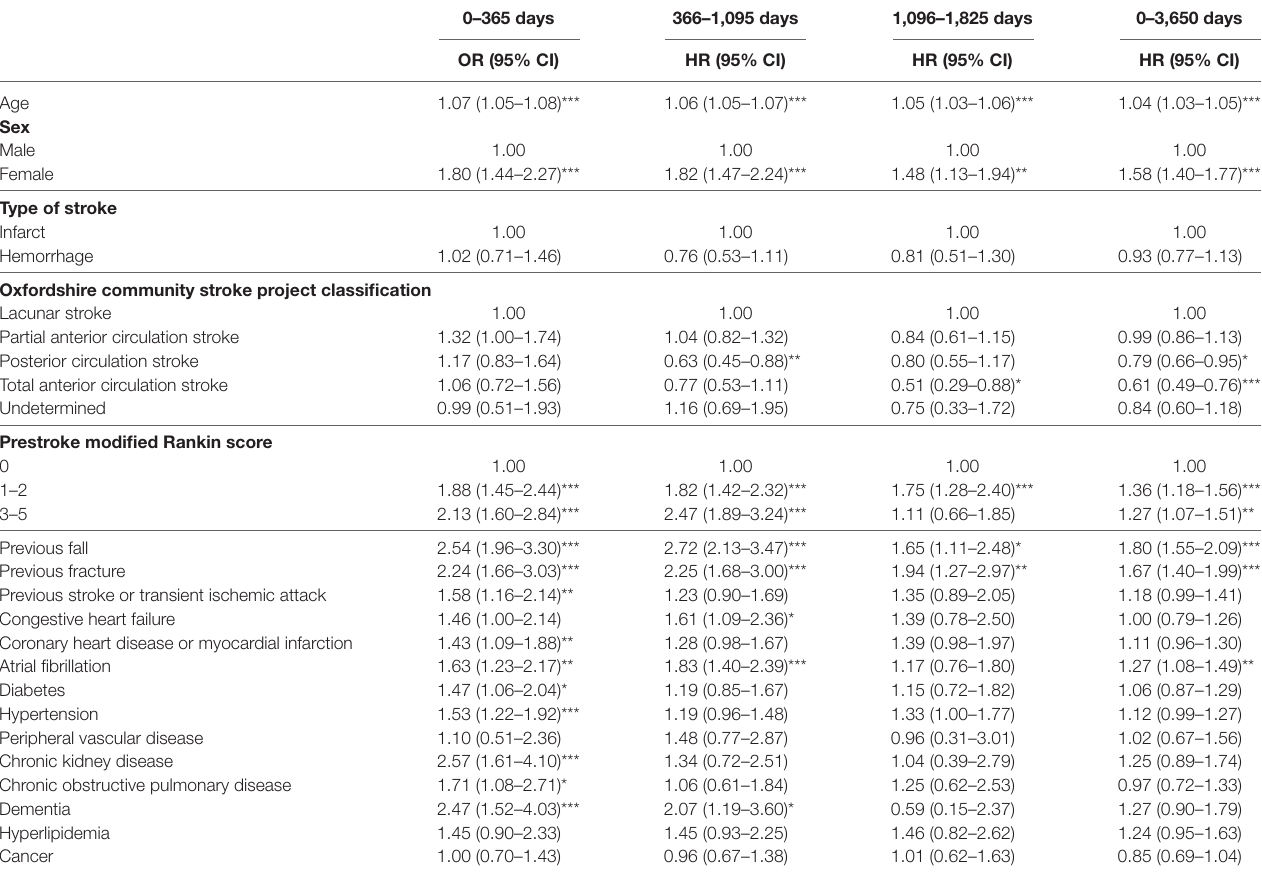
TaBle 2 | Univariate analysis of risk factors for poststroke falls over time after